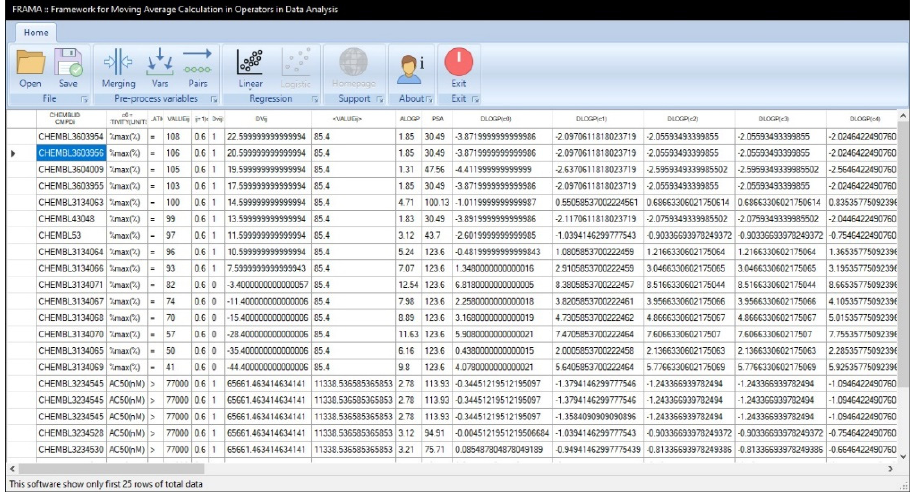
Figure 6. Screenshot of the latest version of the Windows software FRAMA [10,85].